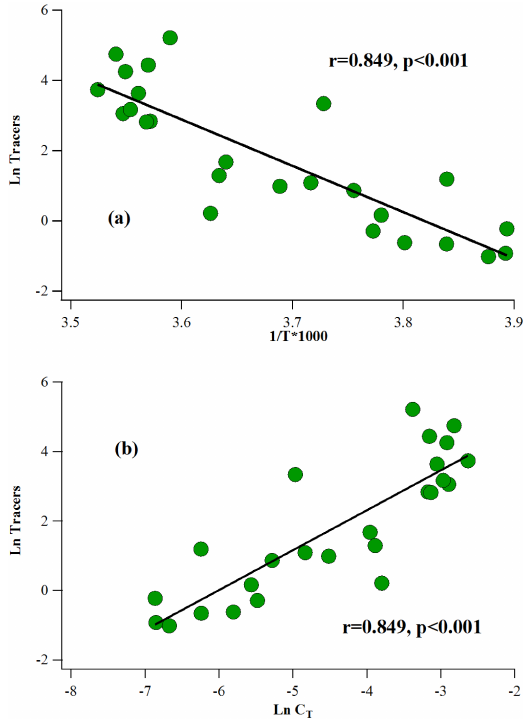
Figure 3. Correlations of SOA I tracers with temperature (a) and C T (b)